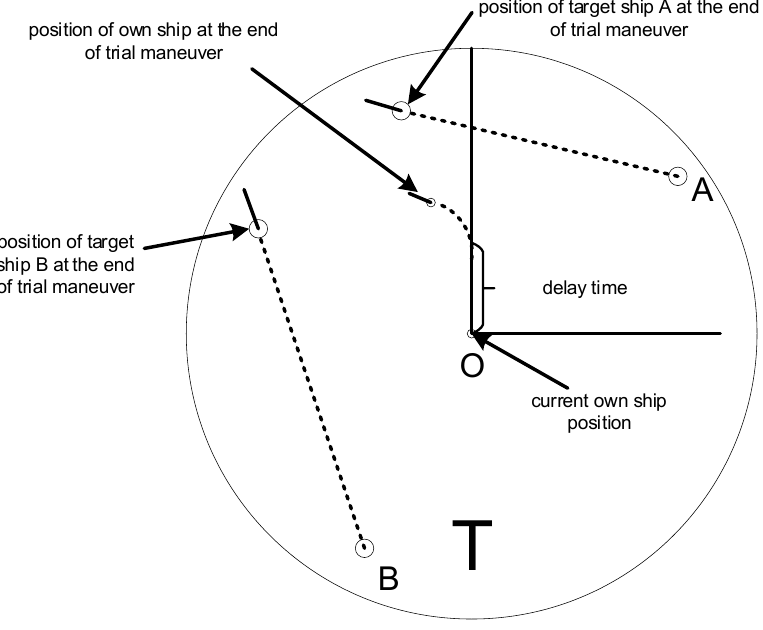
Figure 4. Static trial maneuver in Furuno